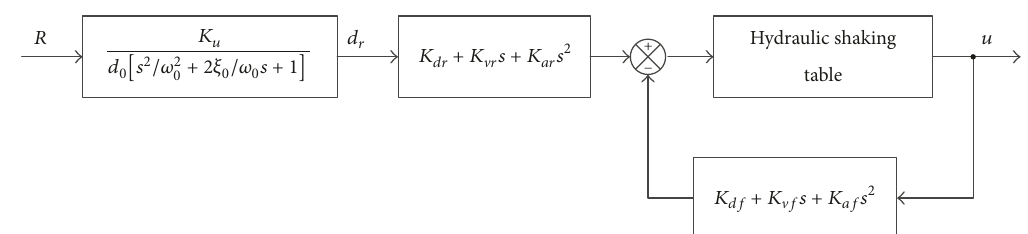
Figure 2: Block diagram of the TVC.